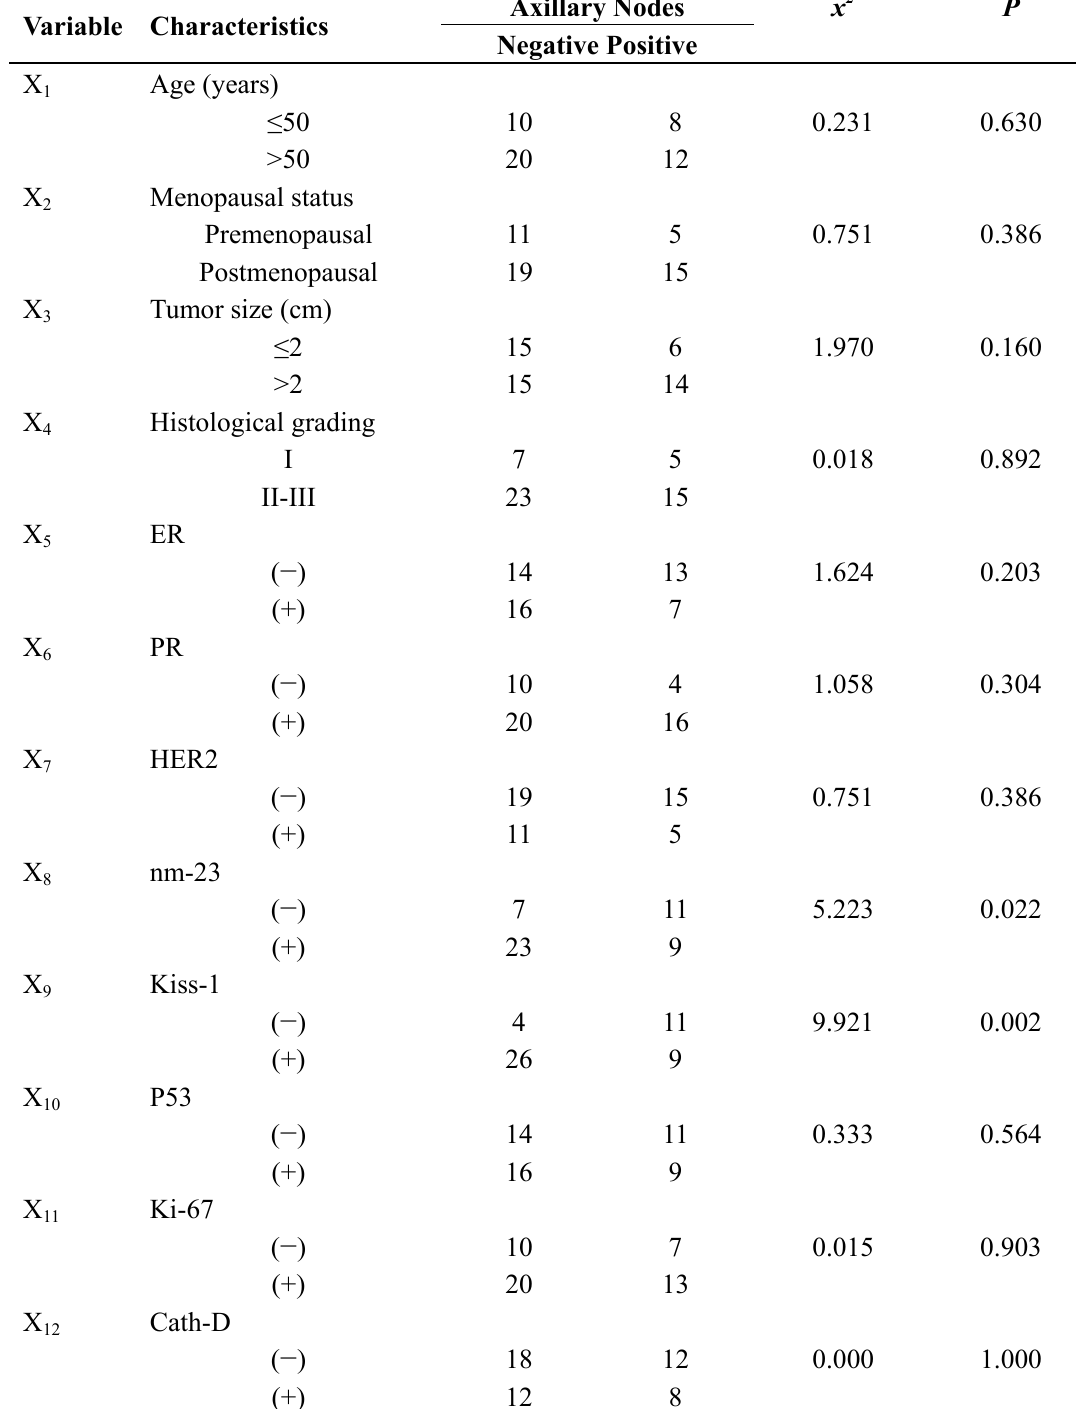
Table 3. Univariate analysis of tumor characteristics and lymph nodes involvement (n = 50).